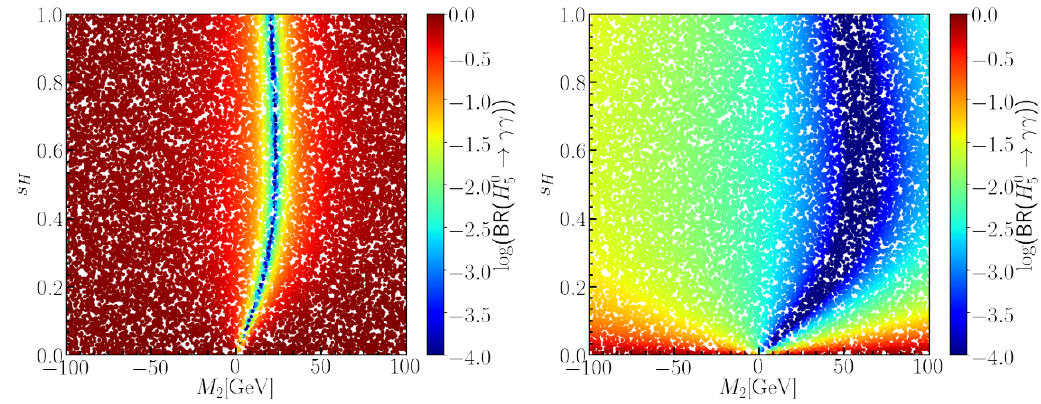
Figure 12 . Dependence of BR( H 0 m 5 = 150 GeV